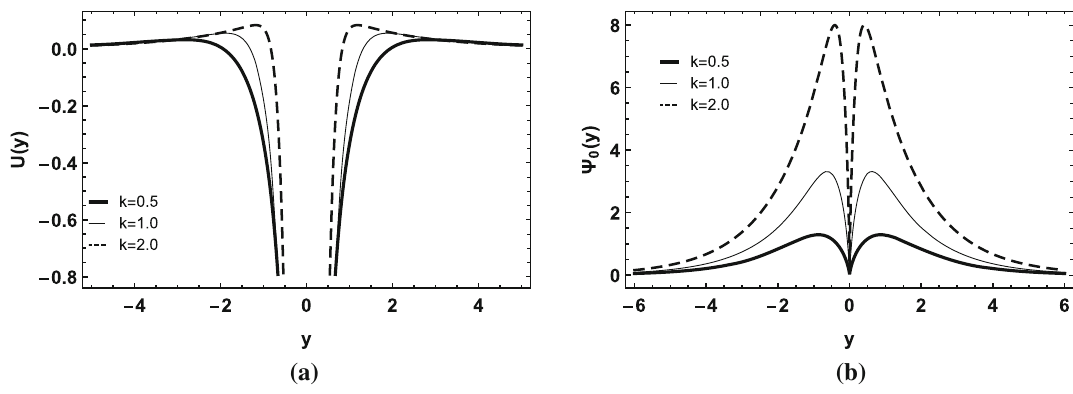
Fig. 11 Plots of the effective potential ( a ), and zero mode ( b ), for n = 2, where k 0 = α = β = 1